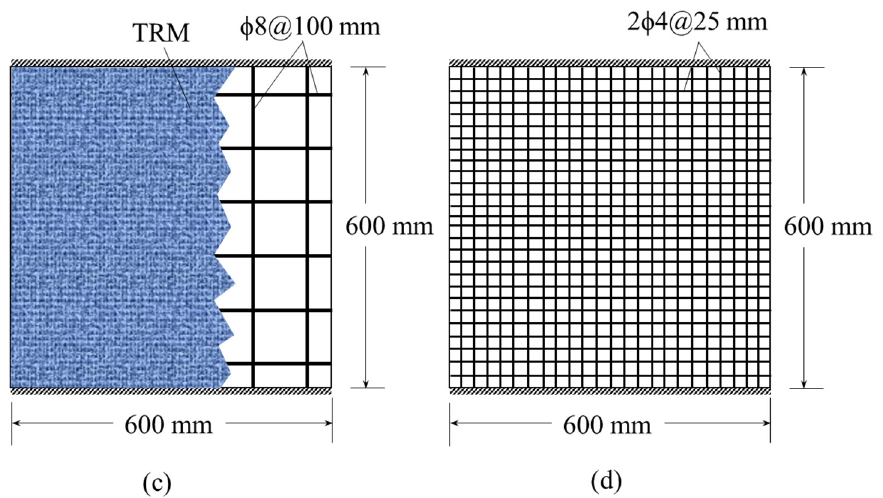
Figure 1. Reinforcement and strengthening details of test specimens. ( a ) Control slab ( b ) CFRP- strengthened specimen ( c ) TRM-strengthened slab ( d ) Welded wire mesh (WWM) (Note: In singly reinforced slabs, the rebar details shown in the figures are applicable for back face, whereas, for doubly reinforced slabs, these details are applicable for both faces; CFRP and TRM strengthening is provided on the back face only).